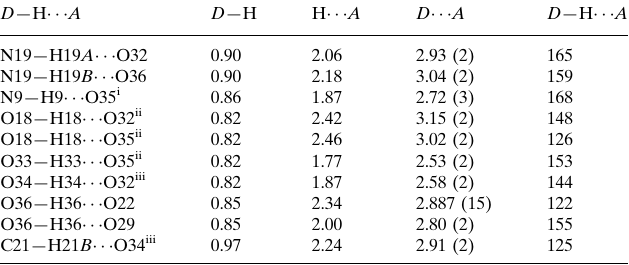
Hydrogen-bond geometry (A˚ , (cid:4)